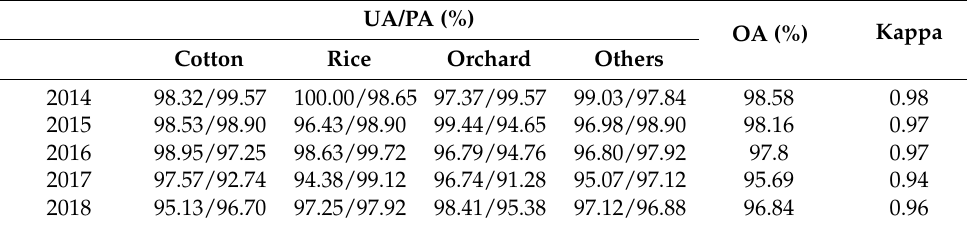
Table 3. Accuracy of the intra-annual crop mapping based on the RF classification method. UA/PA (%) OA (%) Kappa Cotton Rice Orchard